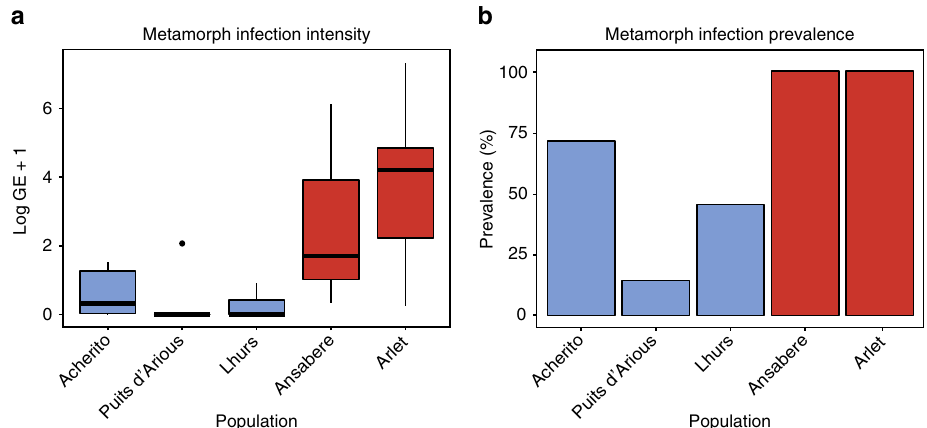
Fig. 2 Bd infection pro fi les of Alytes obstetricans metamorph populations. a Boxplot of Bd infection intensity in metamorphs sampled in 2015 showing reduced infection intensity in enzootic populations (Chi-sq = 59.855, P < 0.0001). Boxes represent 25 and 75 percentile, the horizontal line is the median and whiskers are maximum and minimum values of infection intensity. b Bar chart of Bd infection prevalence in metamorphs. Enzootic populations are coloured in blue, epizootic populations are coloured in red. Sample sizes were: Enzootic = 32 (Acherito = 14, Lhurs = 11, Puits d ’ Arious = 7); Epizootic = 19 (Arlet = 16, Ansabere =